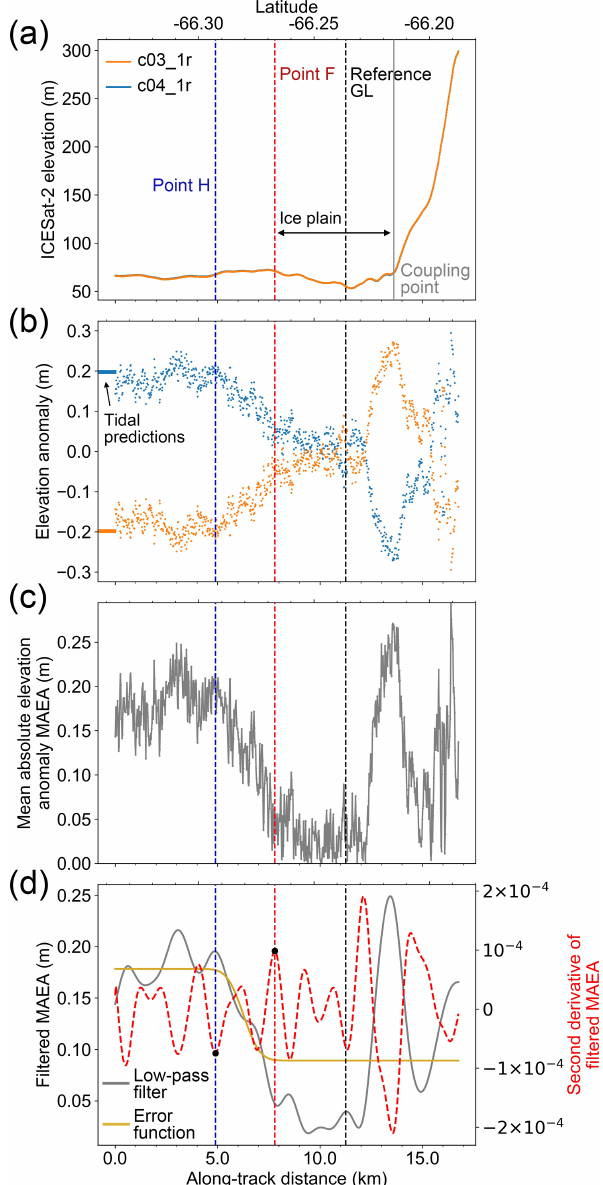
Figure 8. ICESat-2 repeat-track analysis for two right beams from repeat cycles 3 and 4 in beam pair 1 of track 506. The location of track 506 beam pair 1 is shown in Fig. 2. Same as Fig. 5, but showing the existence of an ice plain between the inland limit of tidal flexure (Point F) and the coupling point.